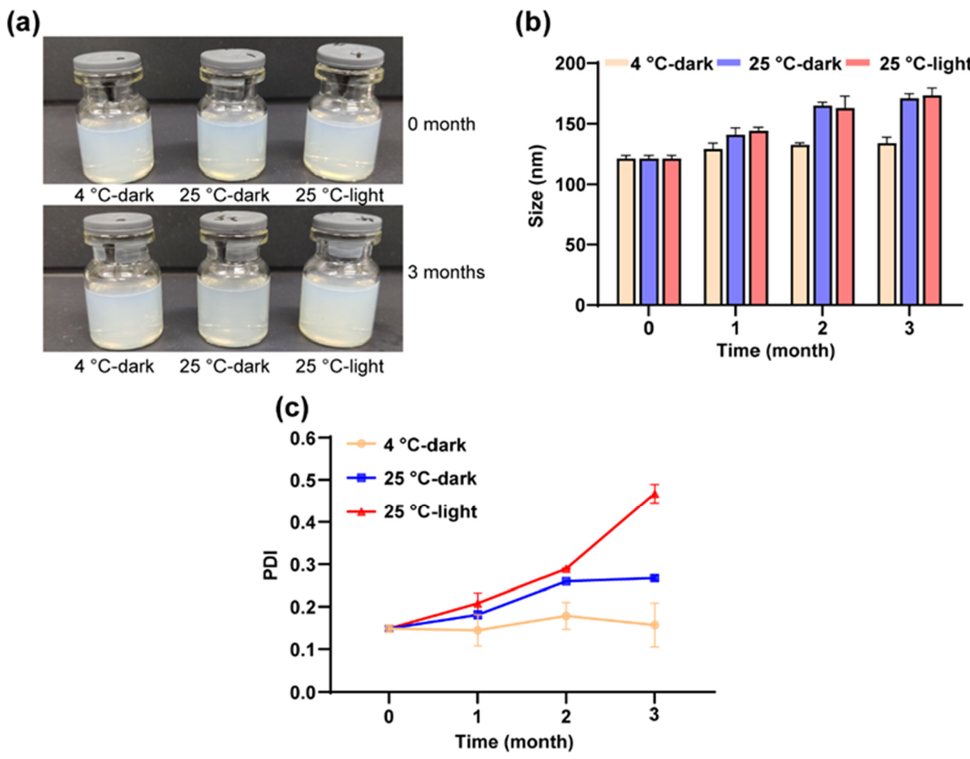
Figure 7. Stability of PR-NLPs. ( a ) Photographs of PR-NLPs at 4 °C in the dark and 25 °C in the dark and light for 0 and 3 months. ( b ) Effect of storage conditions on particle size. ( c ) Effect of storage condition on PDI (n = 3, mean value ± SD).